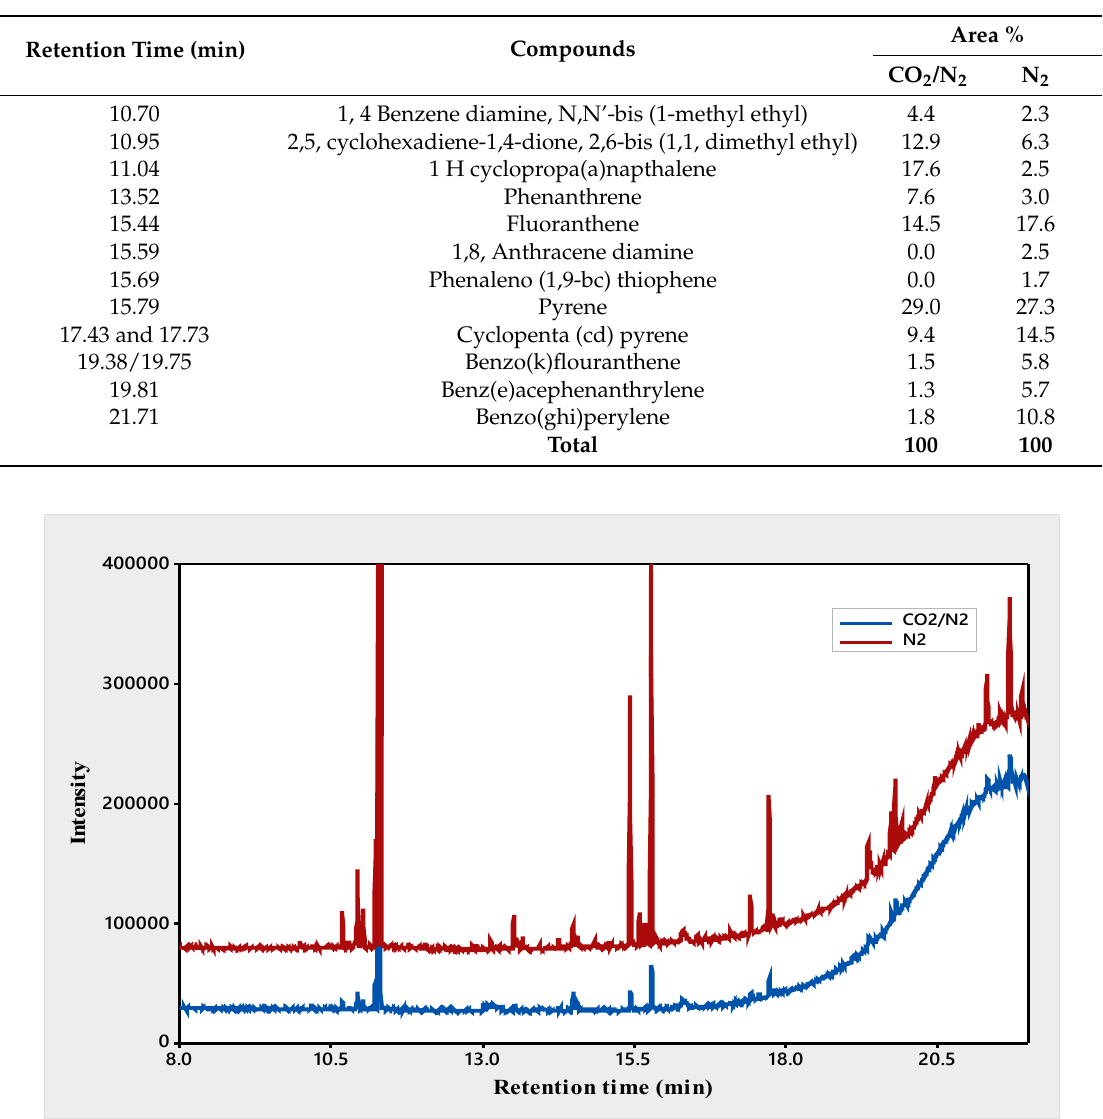
Table 6. Compounds identified by the GC-MS. Figure 10. CO 2 reactivity of the reference char and the THF washed reference char.